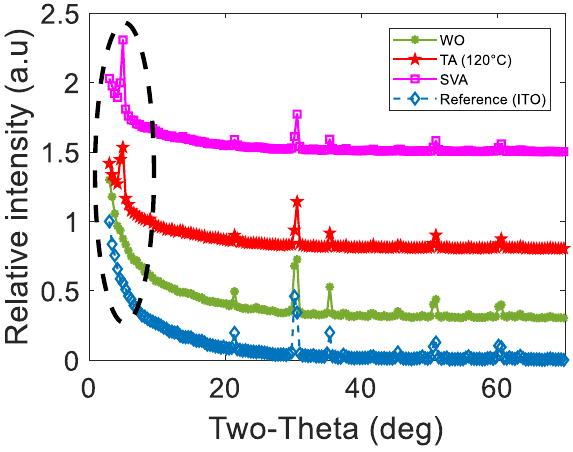
Figure 3. X-ray di ff raction (XRD) pattern of DRCN5T films (Thickness ~160 nm, deposited onto ITO as Figure 3. X-ray diffraction (XRD) pattern of DRCN5T films (Thickness ~ 160 nm, deposited onto ITO the active layers for as the active layers for OSCs).